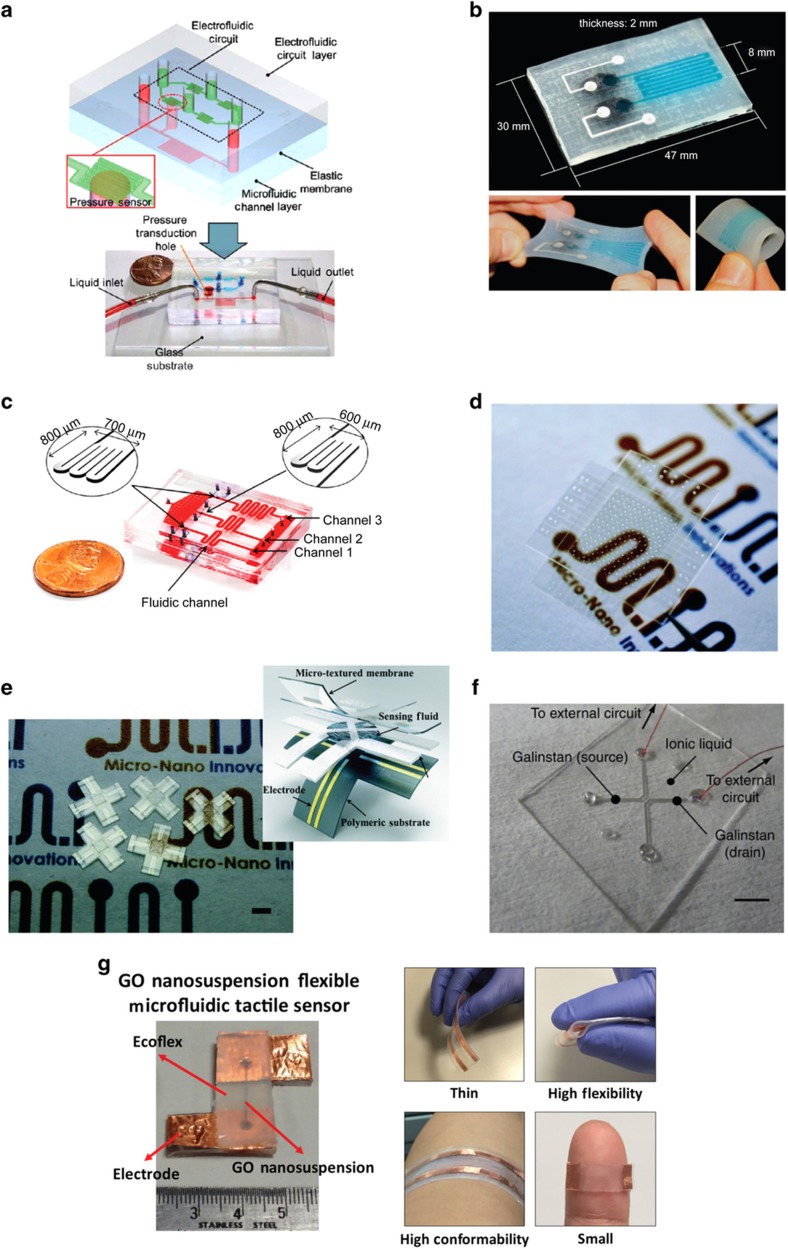
Liquid-state physical sensing platforms. (a) Ionic liquid-based electrofluidic pressure sensor. Schematic illustration depicting the device architecture of the pressure sensor and optical image showing the as-fabricated device. The top electrofluidic circuit and the bottom microfluidic channel were filled with blue and red dyes, respectively. Adapted with permission from Ref. 41. Copyright 2011 The Royal Society of Chemistry. (b) Hybrid soft strain sensor. Optical image showing the as-fabricated sensor with its stretchability and bendability. Adapted with permission from Ref. 42. Copyright 2013 IEEE. (c) Metallic liquid-based microfluidic pressure sensor. Optical image showing the as-fabricated microfluidic pressure sensor with its channel features and dimensions. Adapted with permission from Ref. 43. Copyright 2015 MDPI AG. (d) Iontronic microdroplet array (IMA) flexible tactile sensor. Optical image illustrating the fully fabricated IMA tactile sensor array consisting of 12×12 elements. Adapted with permission from Ref. 105. Copyright 2014 The Royal Society of Chemistry. (e) Microfluidics-based three-dimensional tactile force sensor. Optical image showing the actual fabricated microfluidic tactile sensing devices for three-dimensional force measurements. Scale bar 2 mm. Inset shows the device architecture of the microfluidics-based three-dimensional tactile force sensor. Adapted with permission from Ref. 106. Copyright 2014 The Royal Society of Chemistry. (f) Liquid-state heterojunction sensor. Optical image depicting the actual fabricated liquid-state heterojunction sensor. Scale bar 2.5 mm. Adapted with permission from Ref. 102. Copyright 2014 Macmillan Publishers Limited. (g) Graphene oxide (GO) nanosuspension liquid-state microfluidic tactile sensing device. Optical image showing the fully fabricated liquid-state tactile sensor with its distinctive features. Adapted with permission from Ref. 107. Copyright 2016 Wiley-VCH Verlag GmbH & Co.